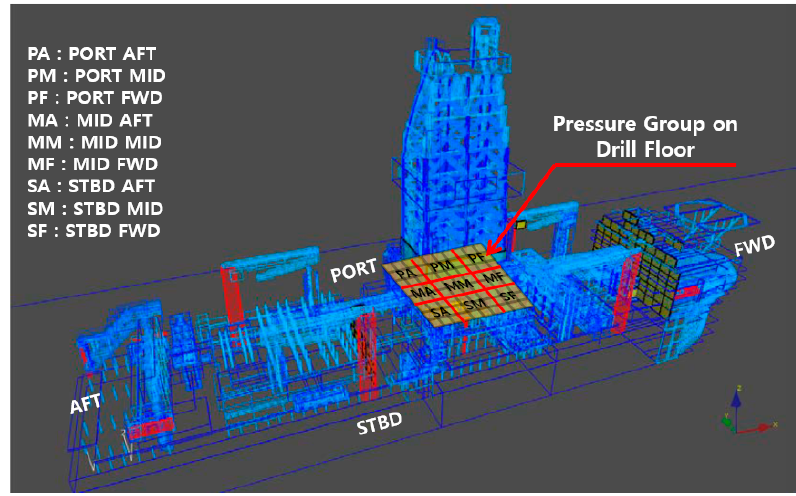
Figure 8. Flame Acceleration Simulator (FLACS) model for explosion simulation.